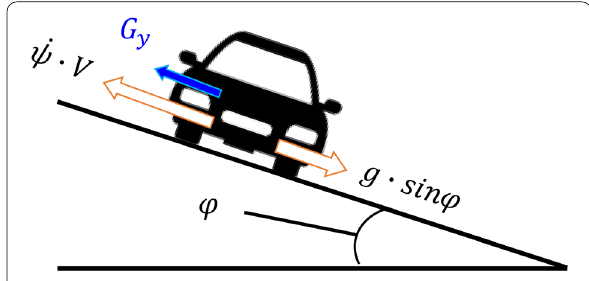
Fig. 3 Effect of road lateral